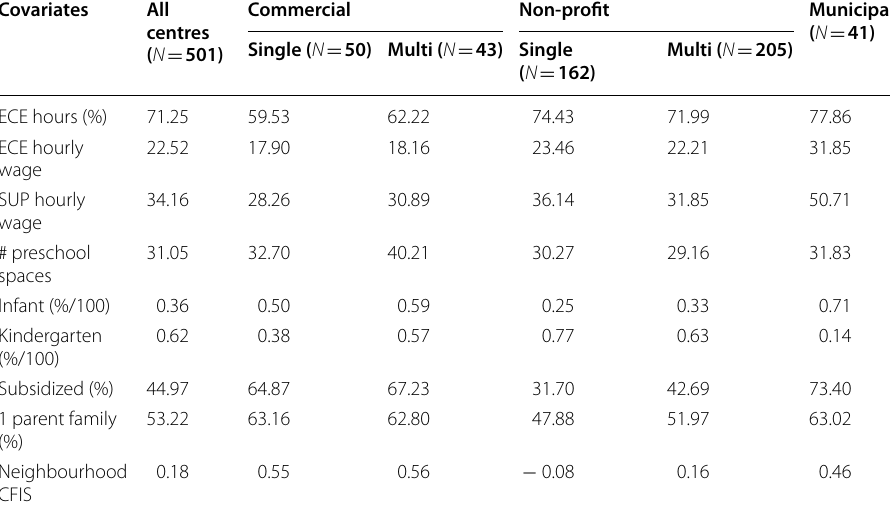
Table 3 Study covariates by centre type Covariates All